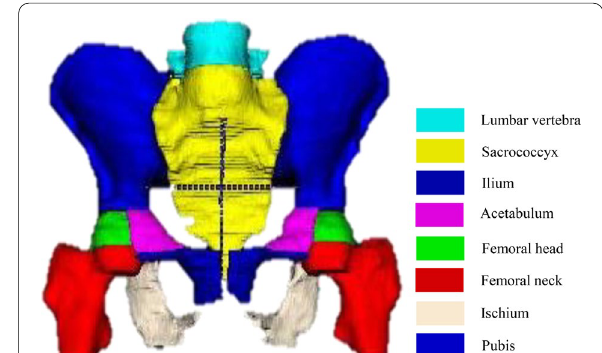
Fig. 2 Reconstruction of manual segmentations of pelvic bones. A multiclass label was created for the patients; 1 2 sacrococcyx, 3 = 6 femoral neck, 7 =